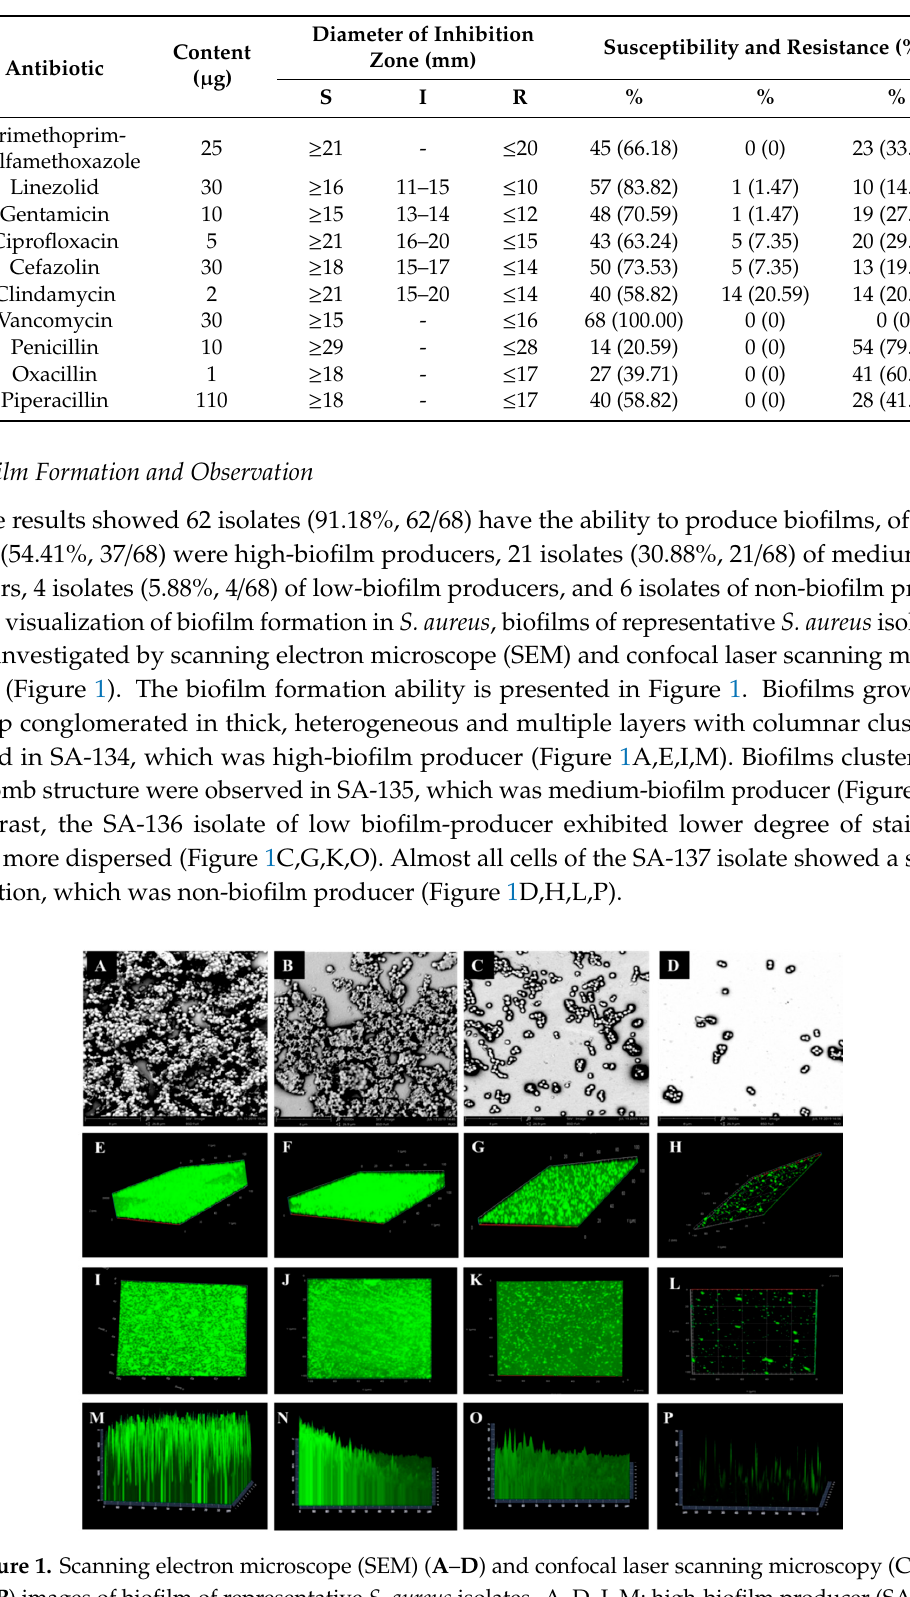
Table 1. Antimicrobial susceptibility test of the 68 S. aureus isolates obtained from raw goat milk samples.